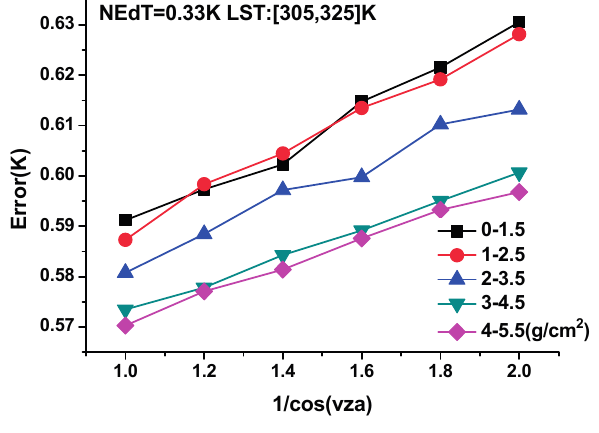
Figure 7. LST retrieval error caused by NE Δ T when LST is varying from 305 K to 325